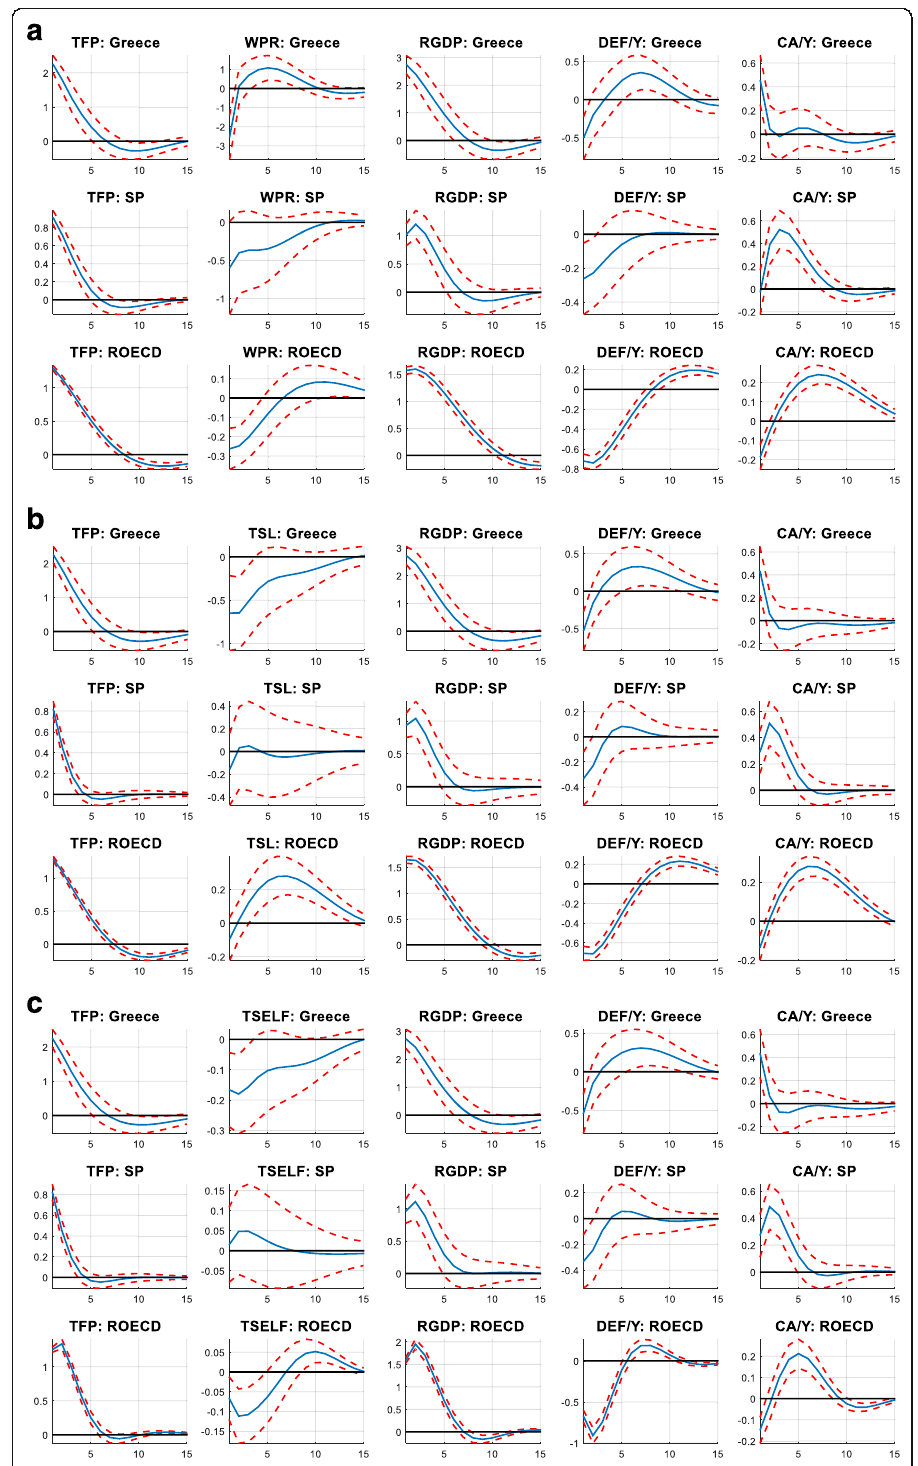
Fig. 4 a Dynamic responses to shock in TFP (vector includes WPR). b Dynamic responses to shock in TFP (vector includes TSL). c Dynamic responses to shock in TFP (vector includes